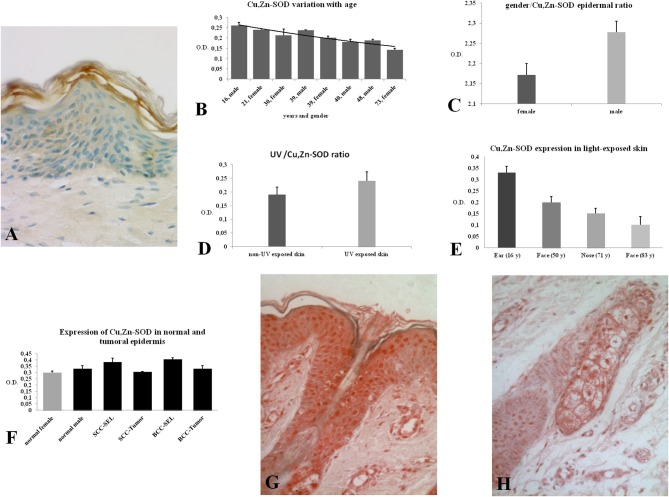
(A) Immunoreactivity of Cu, Zn-SOD in human skin. Cu, Zn-SOD immunoreactive cells are evident throughout the epidermis but also in the dermis. Development with peroxidase. 25x magnification. (B) Expression of Cu, Zn-SOD with reference to age in human epidermis. CU, Zn-SOD densitometric values are consistently higher in males than females during aging. The trend indicates a decreasing value of Cu, Zn-SOD expression with age, independent of gender, and female values are always positioned under the trend line. Of course this and following graphs do not express an absolute value. (C) Expression of Cu, Zn-SOD with reference to gender in human epidermis. As shown in (B), CU, Zn-SOD densitometric evaluation in human epidermis shows a significantly higher level in males than females. p < 0.05. (D) Expression of Cu, Zn-SOD with reference to UV exposure in human epidermis. Densitometric Cu, Zn-SOD analysis of UV exposed vs. UV non exposed regions. UV exposed skin contains significantly more immunoreactive Cu, Zn-SOD than non-UV exposed skin. p < 0.05. (E) Expression of epidermal Cu, Zn-SOD in UV-exposed head regions. Ear, face and nose of UV-exposed human skin with increasing age were compared. OD levels decrease proportionally to age. (F) Cu, Zn-SOD expression in normal and tumoral human epidermis. Superior epithelial layers (SEL) of male basal cell carcinoma (BCC-SEL)-and of male spinocellular carcinoma (SCC-SEL) show higher densitometric values than deeper basal and squamous tumors. (G) Expression of Cu, Zn-SOD in a hair follicle. Cu, Zn-SOD immunopositivity is shown as a red stain. Note that nuclei are also immunoreactive. Development with alkaline phosphatase. 25x Magnification. (H) Expression of Cu, Zn-SOD in a sebaceous gland. Immunoreactivity of Cu, Zn-SOD in sebaceous glands is localized to the cytoplasm and nuclei of the clear secreting cells. Development with alkaline phosphatase. 25x Magnification.